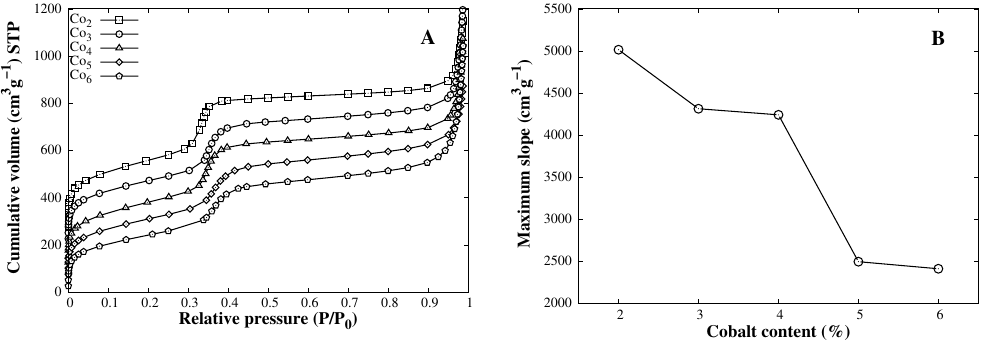
Figure 1. ( A ) Nitrogen adsorption isotherms of MCM-41–Co catalysts. ( B ) Offset added for each catalyst to differentiate curves and maximum slope of the capillary condensation